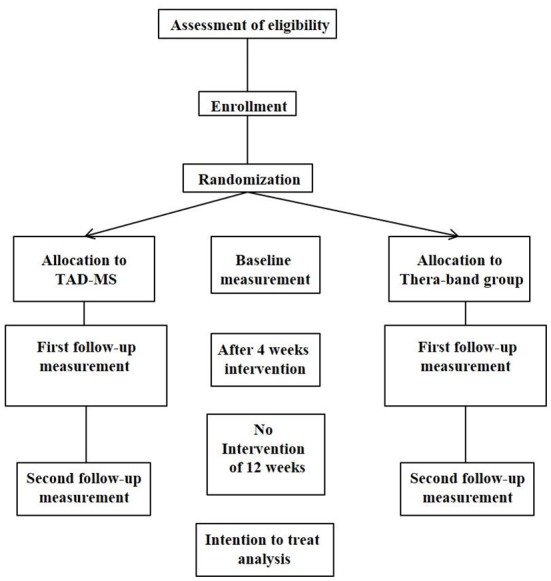
Study flow chart.